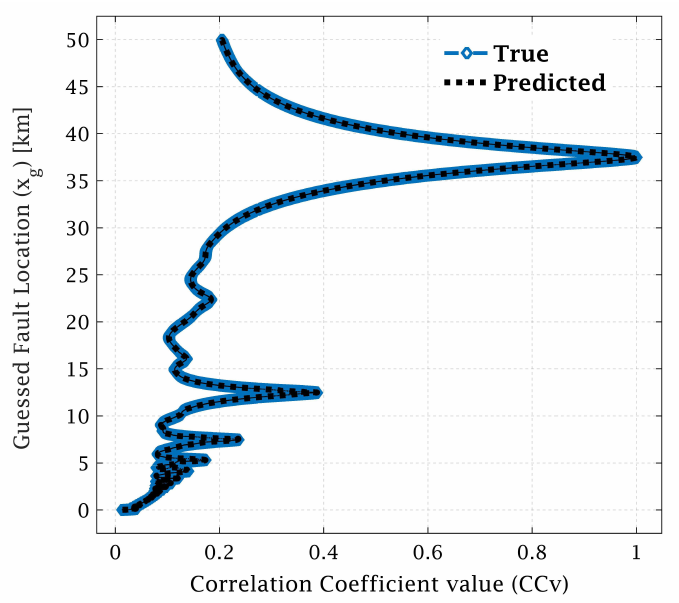
Figure 18. Response plot of GPR exponential at one of the storage locations, i.e., 37,500